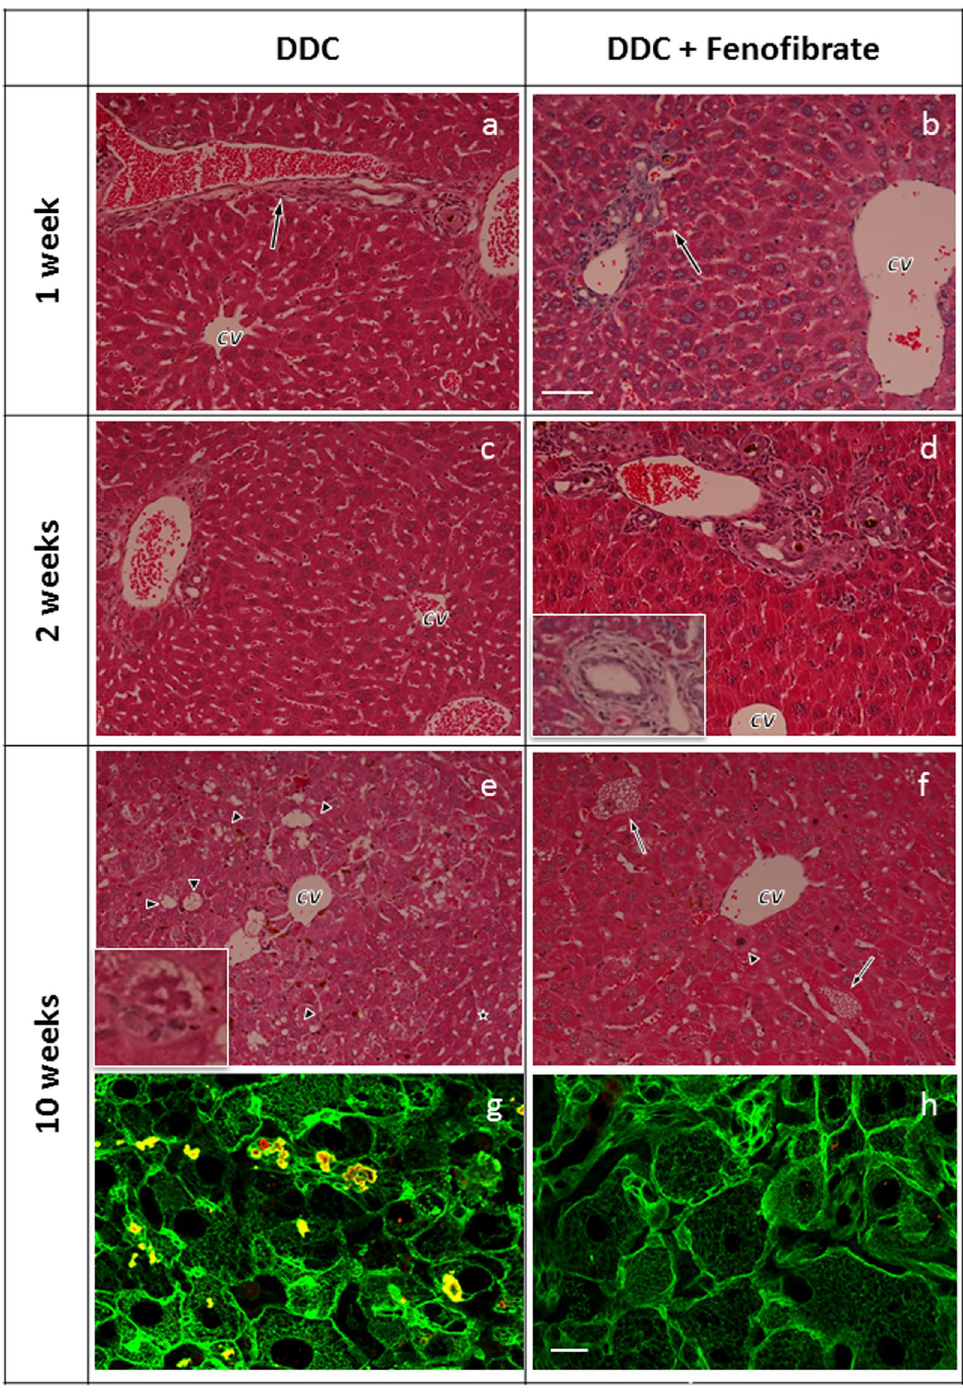
Figure 7. Liver morphology and immune fluorescence microscopy of DDC- and DDC/fenofibrate-treated mice. DDC treatment for 1 week with ( a ) or without ( b ) fenofibrate co-treatment results in irregular extension of portal tracts (arrows) with elongation of interlobular bile ducts displaying irregular epithelium mostly containing inspissated brown pigment plugs in their lumina. These features are exaggerated by DDC feeding for 2 weeks ( c , d ) but are identical in the DDC ( c ) and DDC/fenofibrate group ( d ), except for more eosinophilic homogenous cytoplasm in hepatocytes in the DDC/fenofibrate group; in some portal tracts bile ducts show signs of periductal sclerosis (arrow in the inset in ( d )). DDC intoxication for 10 weeks ( e ) results (in addition to portal changes) in enlargement (ballooning) of centrilobular hepatocytes with enlarged nuclei, accumulation of fat vacuoles (arrowheads in ( e ); compare hepatocyte changes in the centrilobular area with smaller hepatocytes arranged in regular plates in the periphery of the lobule, asterisk) and formation of MDBs (inset in ( e ) with higher magnification). In contrast, co-treatment with fenofibrate ( f ) prevented MDB formation; hepatocytes in the centrilobular area are monomorphic and steatosis is much less pronounced (some hepatocytes